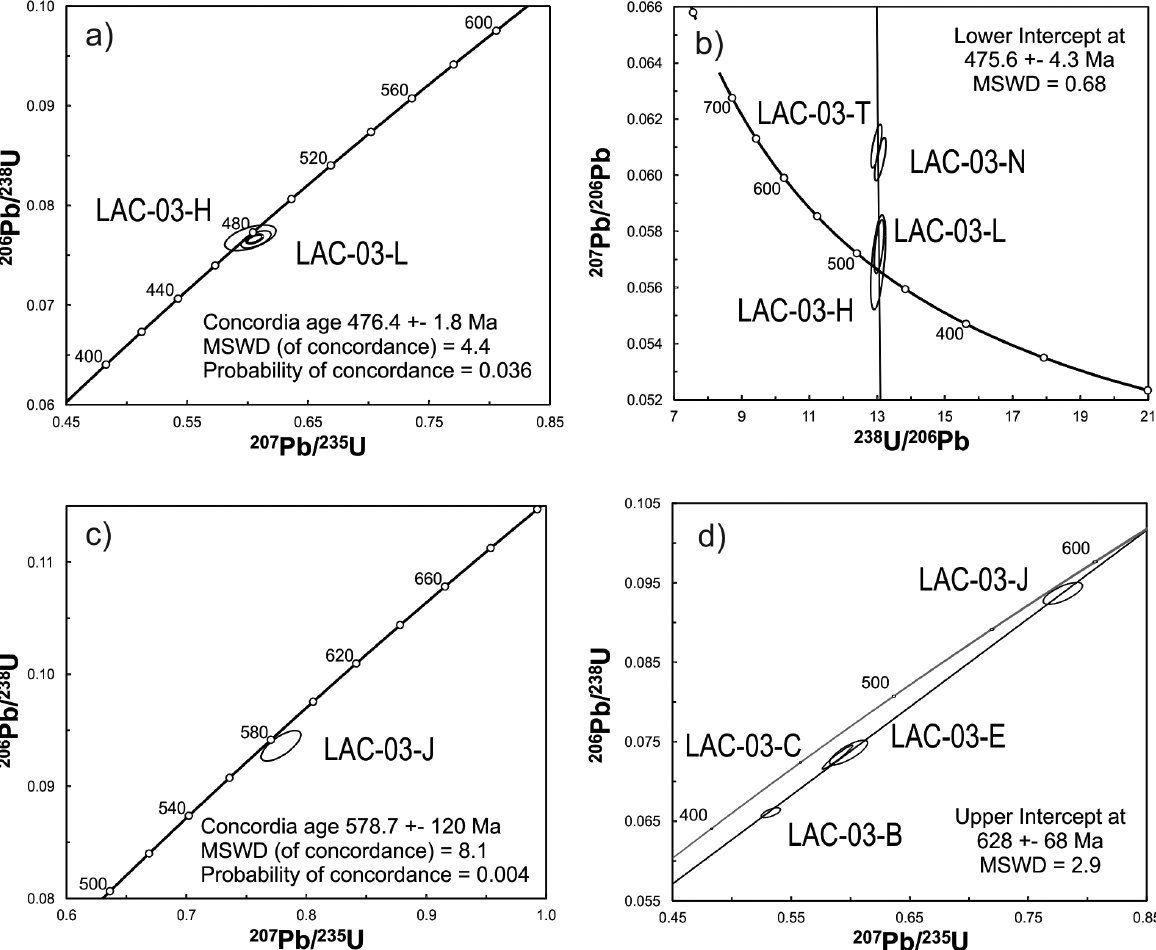
Figure 6 - Concordia diagrams for monazites from sample LAC-03 of the Itaoca Granite. a) Concordia age of 476.4 ± 1.8 Ma for grains H and L, interpreted as the best estimate of crystallization; b) discordia line for grains H, L, N and T with lower intercept at 475.6 ± 4.3 Ma; c) Concordia age of ca. 579 Ma for grain J; d) upper intercept for grains B, E and J at ca 630 Ma (see text for